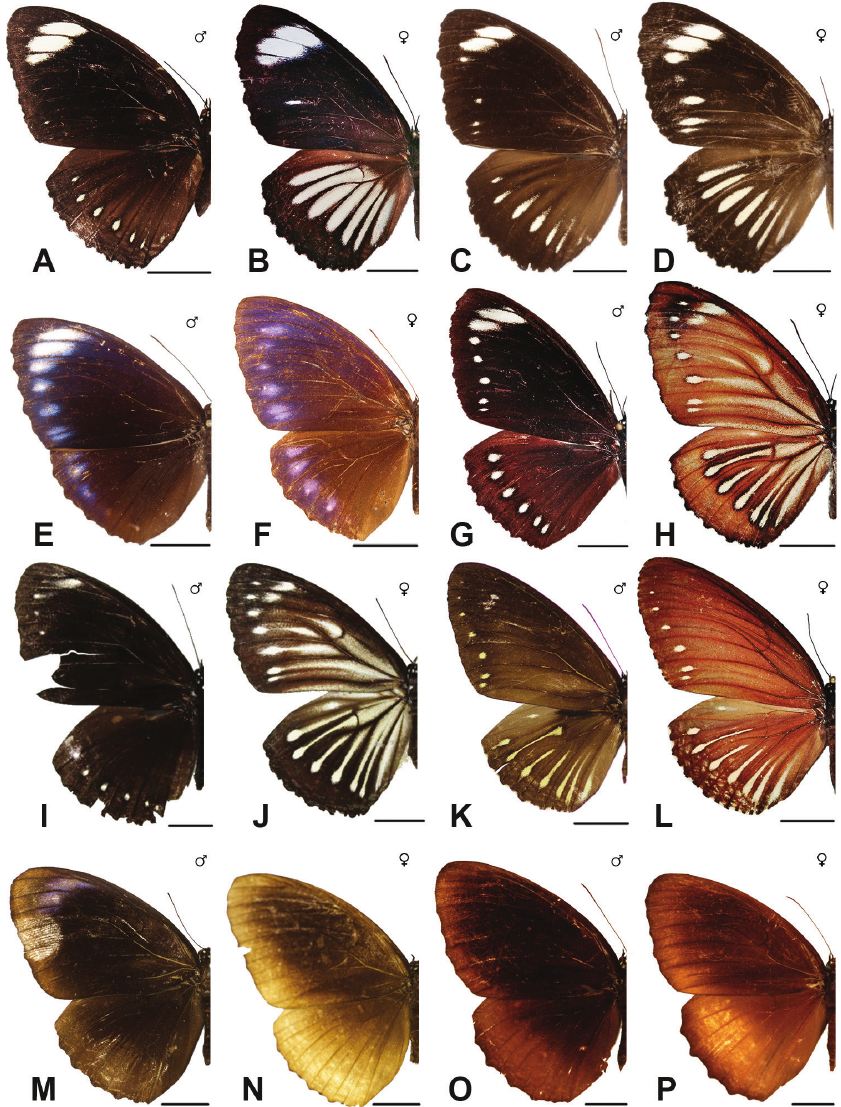
Figure 15. A melias melias ♂ D NMNH Philippines: Luzon, Cavite, Puerto Azul B melias melias ♀ D SMFD Philippines: Luzon, Sierre Madre Mountains C melias malis ♂ D NHM Philippines: Quezon, Po- lillo Island D melias malis ♀ D NHM Philippines: Luzon, Los Baños E beza beza ♂ D NHM Philippines: Mindanao F beza beza ♀ D NHM Philippines: Mindanao G sansoni sansoni ♂ D SMFD Philippines: Negros H sansoni sansoni ♀ D SMFD Philippines: Negros I sansoni aklanensis ♂ D UPC Philippines: Panay, Aklan; Paratype J sansoni aklanensis ♀ D UPC Philippines: Panay, Aklan; Paratype K luteofasciata ♂ D OPC Philippines: Mindanao, Penangudltan, Upian River, City of Davao; Holotype L luteofasciata ♀ D SMFD Philippines: Mindanao, South Cotabato, Mt. Matutum M vitellia vitellia ♂ D NHM Indonesia: Maluku, Ambon N vitellia vitellia ♀ D NHM Indonesia: Maluku, Ambon O vitellia viminalis ♂ D NHM Indonesia: Maluku, Buru P vitellia viminalis ♀ D NHM Indonesia: Maluku,